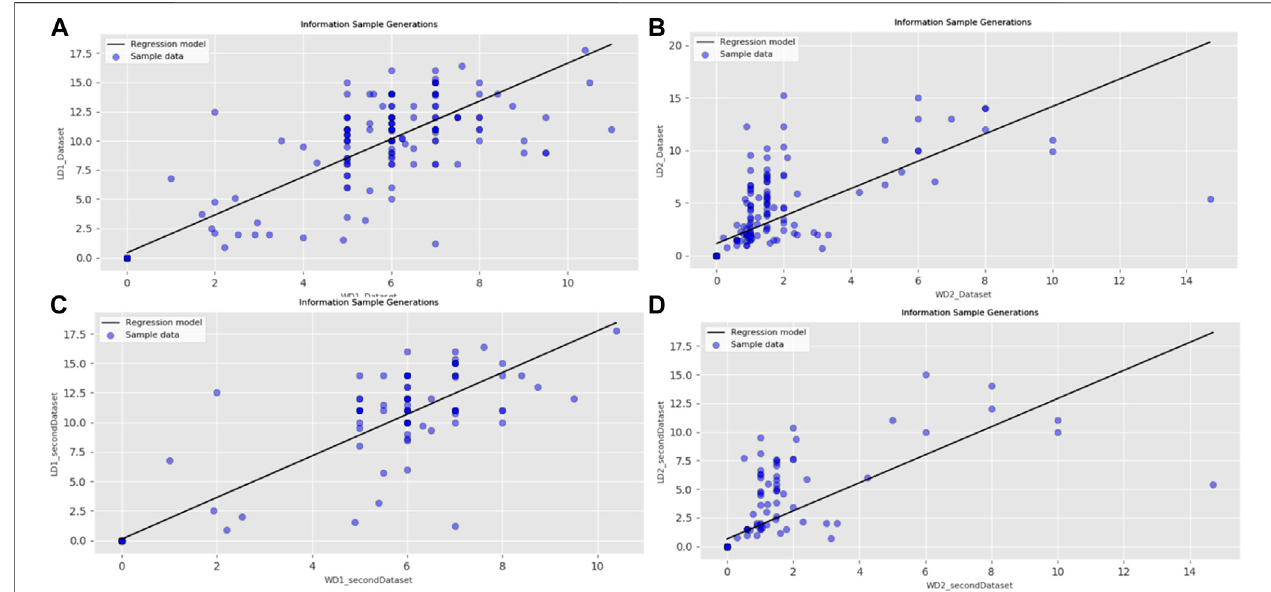
FIGURE 7 | Examination of plan data frequency, Source: Author: (A) 1 Frequency of ground fl oor plan data house number, (B) 2 Frequency of ground fl oor plan data house number, (C) 1 Frequency of fi rst fl oor plan data house number, (D) 2 Frequency of fi rst fl oor plan data house number.